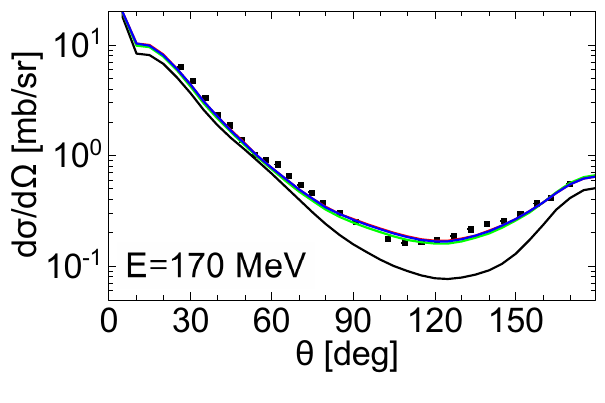
= 170 MeV. Black, green, p , AV18 + AV18 + BR(C) [ , and 1000 I ] 0.5